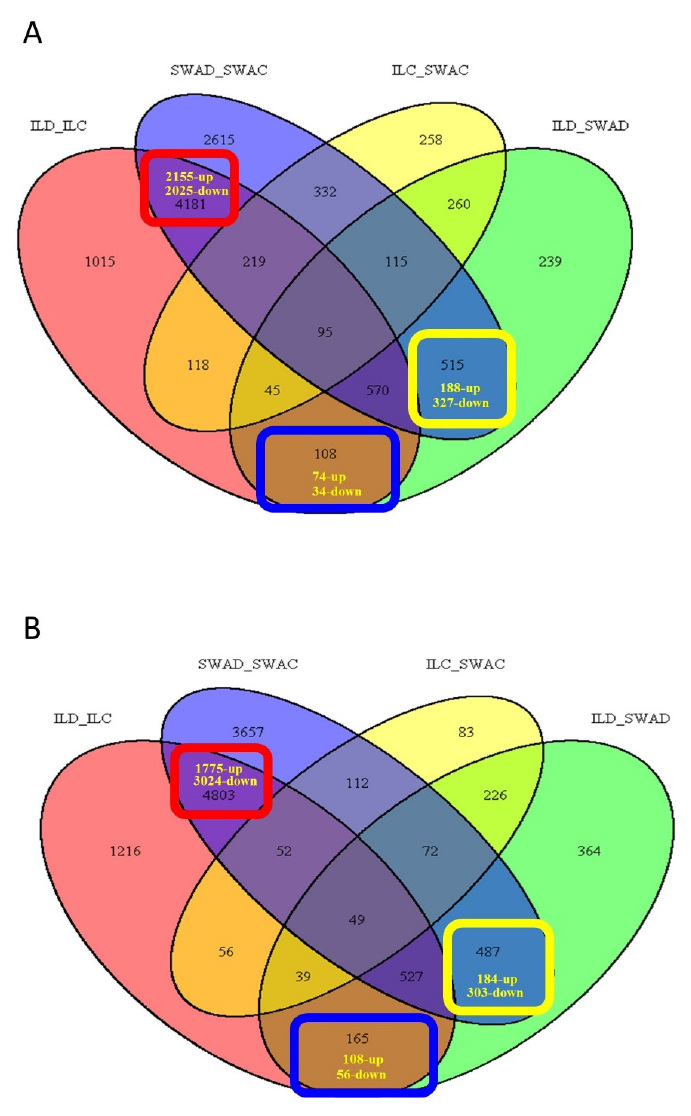
Figure 2. Gene di ff erential expression and identification. Venn diagram of di ff erentially Figure 2. Gene differential expression and identification. Venn diagram of differentially expressed genes (DEGs) for flag-leaf ( A ) and panicle ( B ) tissues in Swarna and DTY-IL under reproductive drought stress (RDS) at a false discovery rate (FDR) adjusted p -value < 0.05 and − 1 ≤ log 2 -ratio ≤ +1 (fold change ≥ 2 and ≤ 0.5). The three highlighted boxes for each tissue represent the common DEGs (red), unique to Swarna (yellow), and unique to DTY-IL (blue). SWAC = Swarna control, SWAD = Swarna under RDS, ILC = DTY-IL control, ILD = DTY-IL under RDS. Table 1. A summary of GO enrichment analysis of differentially expressed genes (DEGs) common to both genotypes, and unique to DTY-IL and Swarna for flag-leaf and panicle tissues under RDS. DEGs of Interest